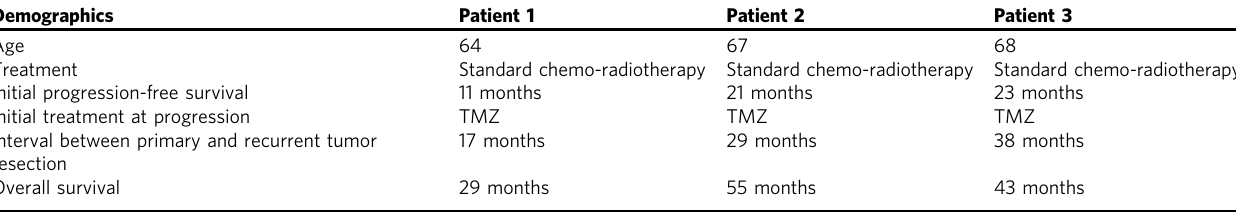
Table 2 Treatment and survival information for patients who provided primary and recurrent tumor samples